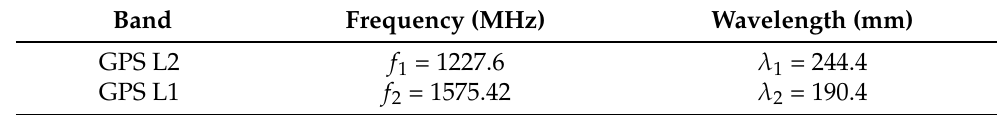
Table 2. Design frequency